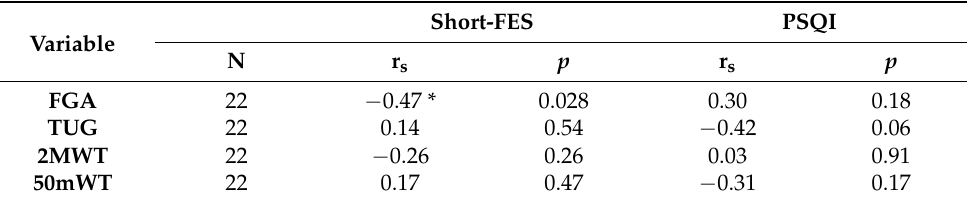
Table 2. Spearman’s correlation assessing the relationship between the baseline scores on the short Falls Efficacy Scale (short-FES), the Pittsburgh Sleep Quality Index (PSQI), and four indexes of motor performance (FGA score, time on the TUG, distance walked in the 2MWT, and time on the 50mWT) in people with multiple